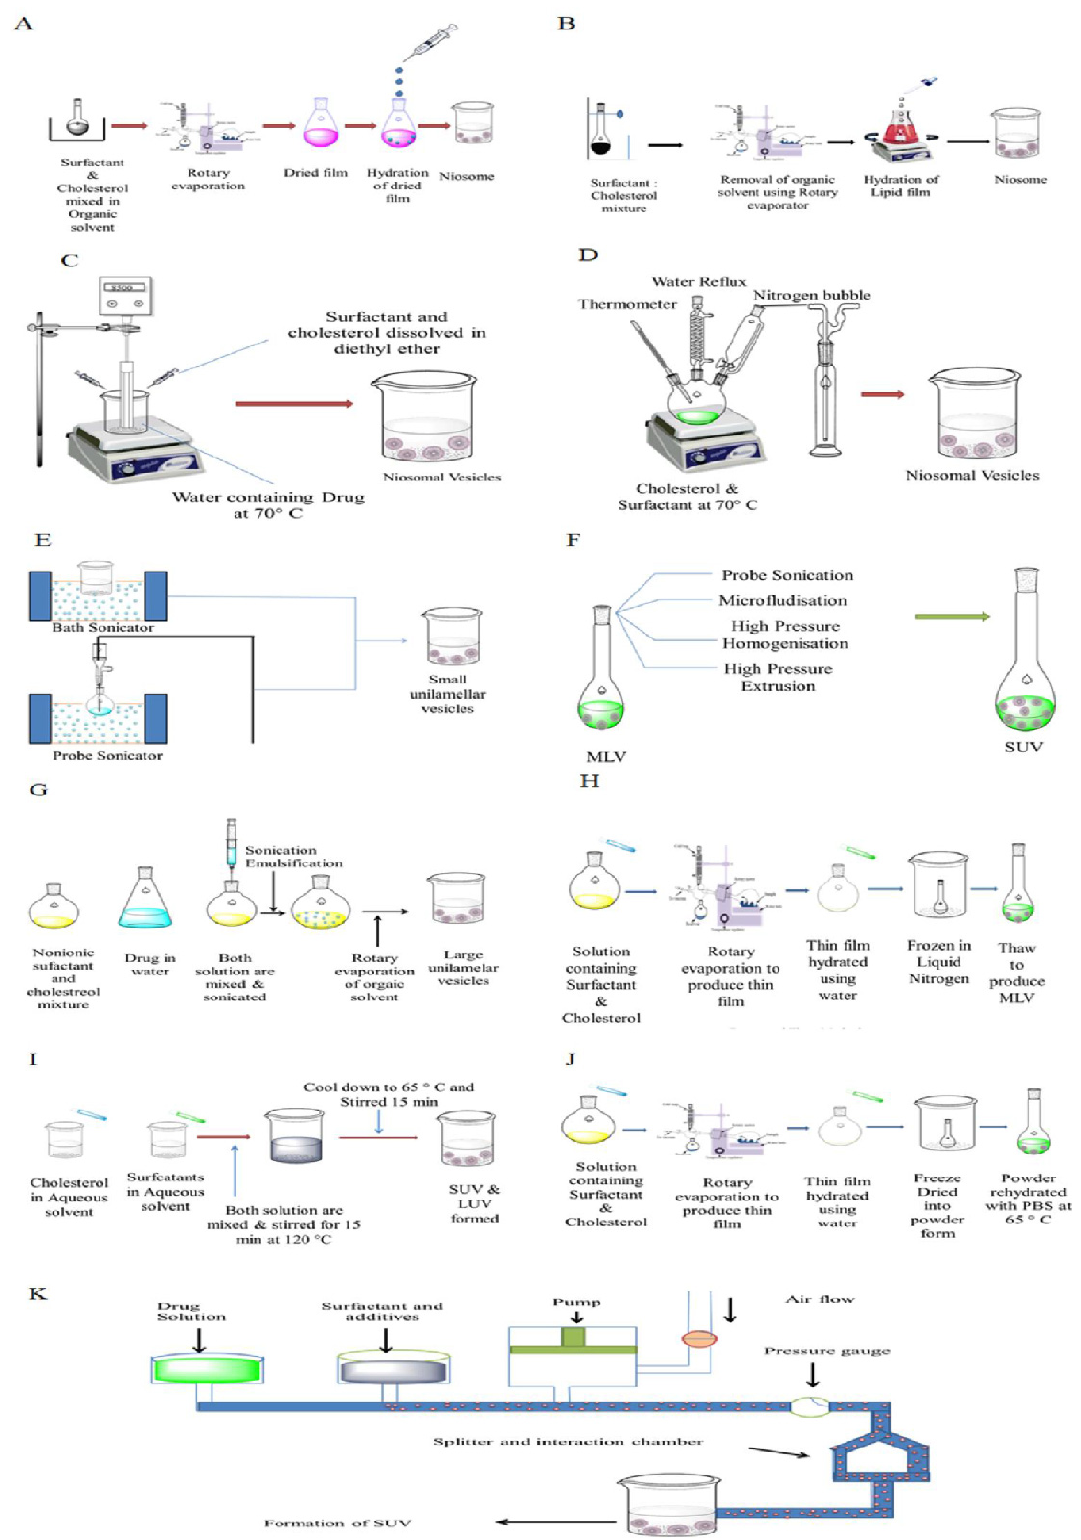
Figure 2. Schematic representation of different techniques for preparation of niosomes: ( A ) thin-film hydration, ( B ) hand-shaking, ( C ) ether injection, ( D ) bubble, ( E ) sonication, ( F ) proniosome technology, ( G ) reverse phase evaporation, ( H ) freeze-and-thaw, ( I ) heating, ( J ) dehydration and rehydration and ( K ) microfludics. (Reproduced from [48] with permission from Elsevier and in accordance with the Creative Commons Attribution License).